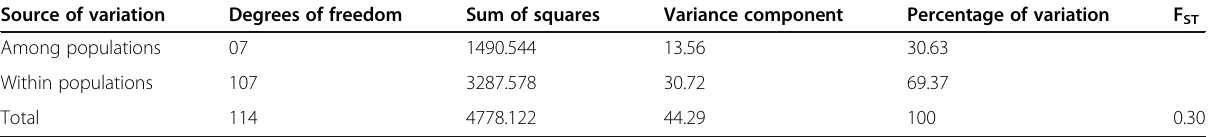
Table. 6 Analysis of molecular variance (AMOVA) showing variation in the collected populations of I . griffithii Source of variation Degrees of freedom Sum of squares Variance component Percentage of variation F ST Among populations